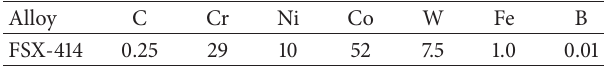
Table 1: Chemical composition of FSX-414 superalloy (wt%). Alloy